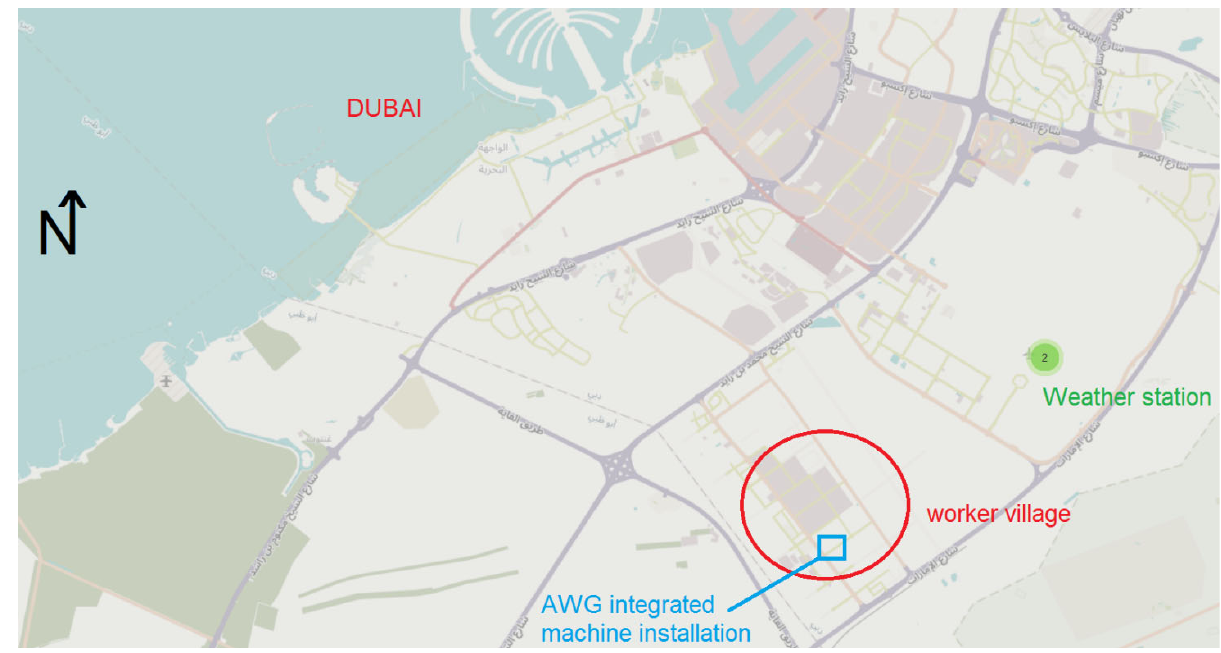
Figure 2. Integrated machine installation site.